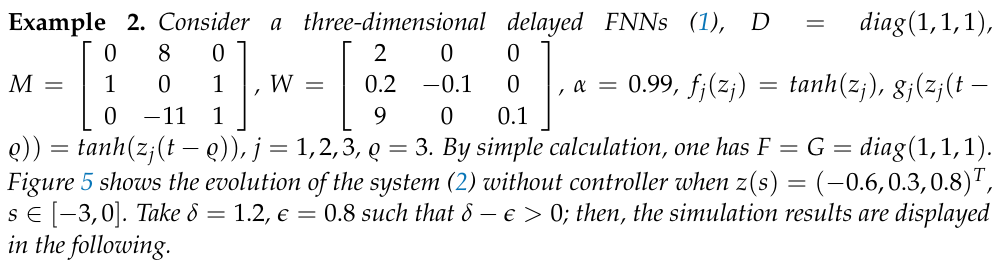
Figure 4. Trajectories of ( a ): z ( t ) ; ( b ): u ( t ) of Example 1 based on optimization scheme